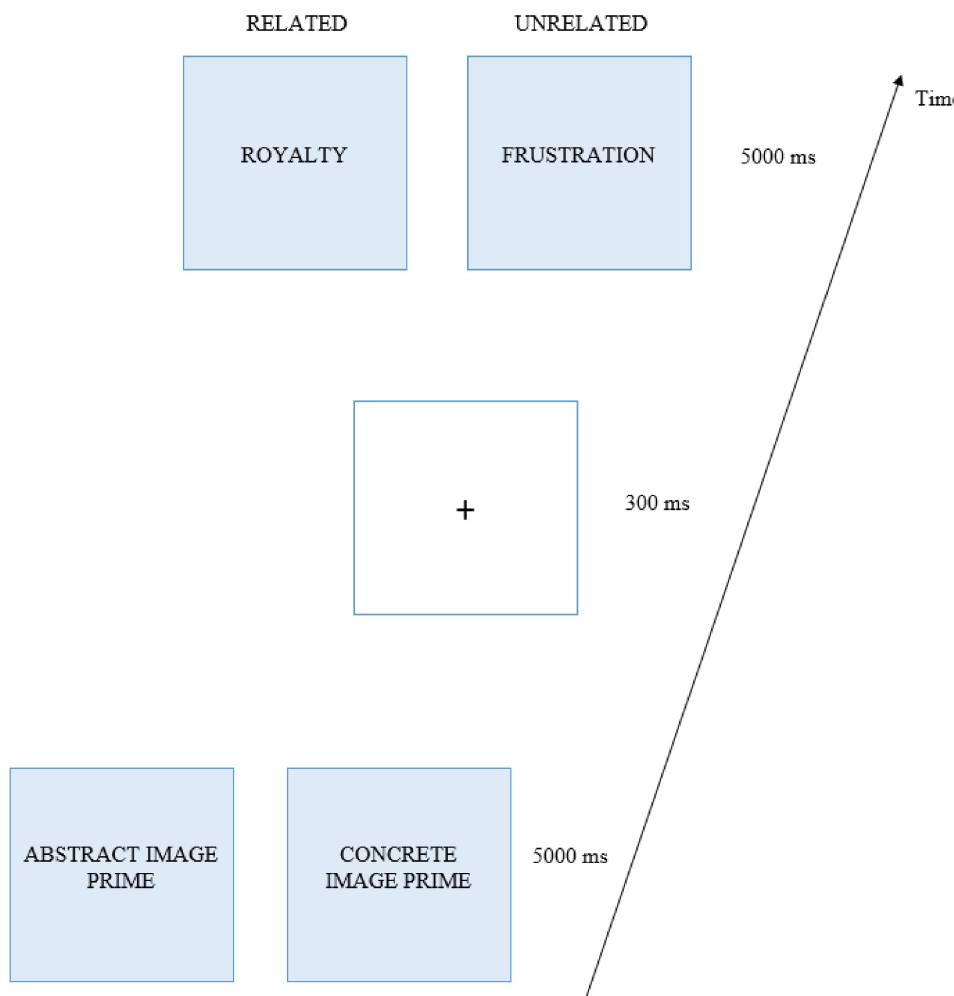
Fig 1. Trial procedure for the concept royalty (“royaute´” in French). Note. For this concept, each participant was exposed to either the abstract or the concrete image prime followed by the related or unrelated target word. The trial procedure for Experiment 1 consisted of only the abstract images paired with related or unrelated words, whereas Experiment 2 also had concrete images in addition to the abstract pictures. The abstract image stimulus is a fractal created by Sven Geier (http://www.sgeier.net/fractals/fractals/07/The%20Road%20Ahead.jpg) and the concrete image stimulus is a coronation picture credited to the National Film Board of Canada. Phototh è que. Library and Archives Canada, PA-196667; CC BY 2.0;